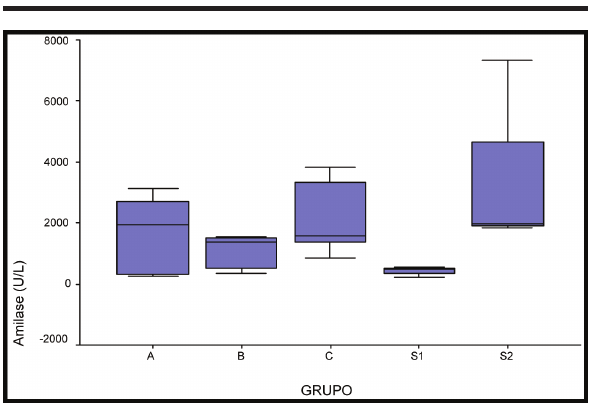
FIGURE 4 - Fotomicrograph. Severe, difuse, necrotic FIGURE 1 - Level of amylase in each group, confirming pancreatic tissue. Group C, rabbit 1. the presence of acute pancreatitis